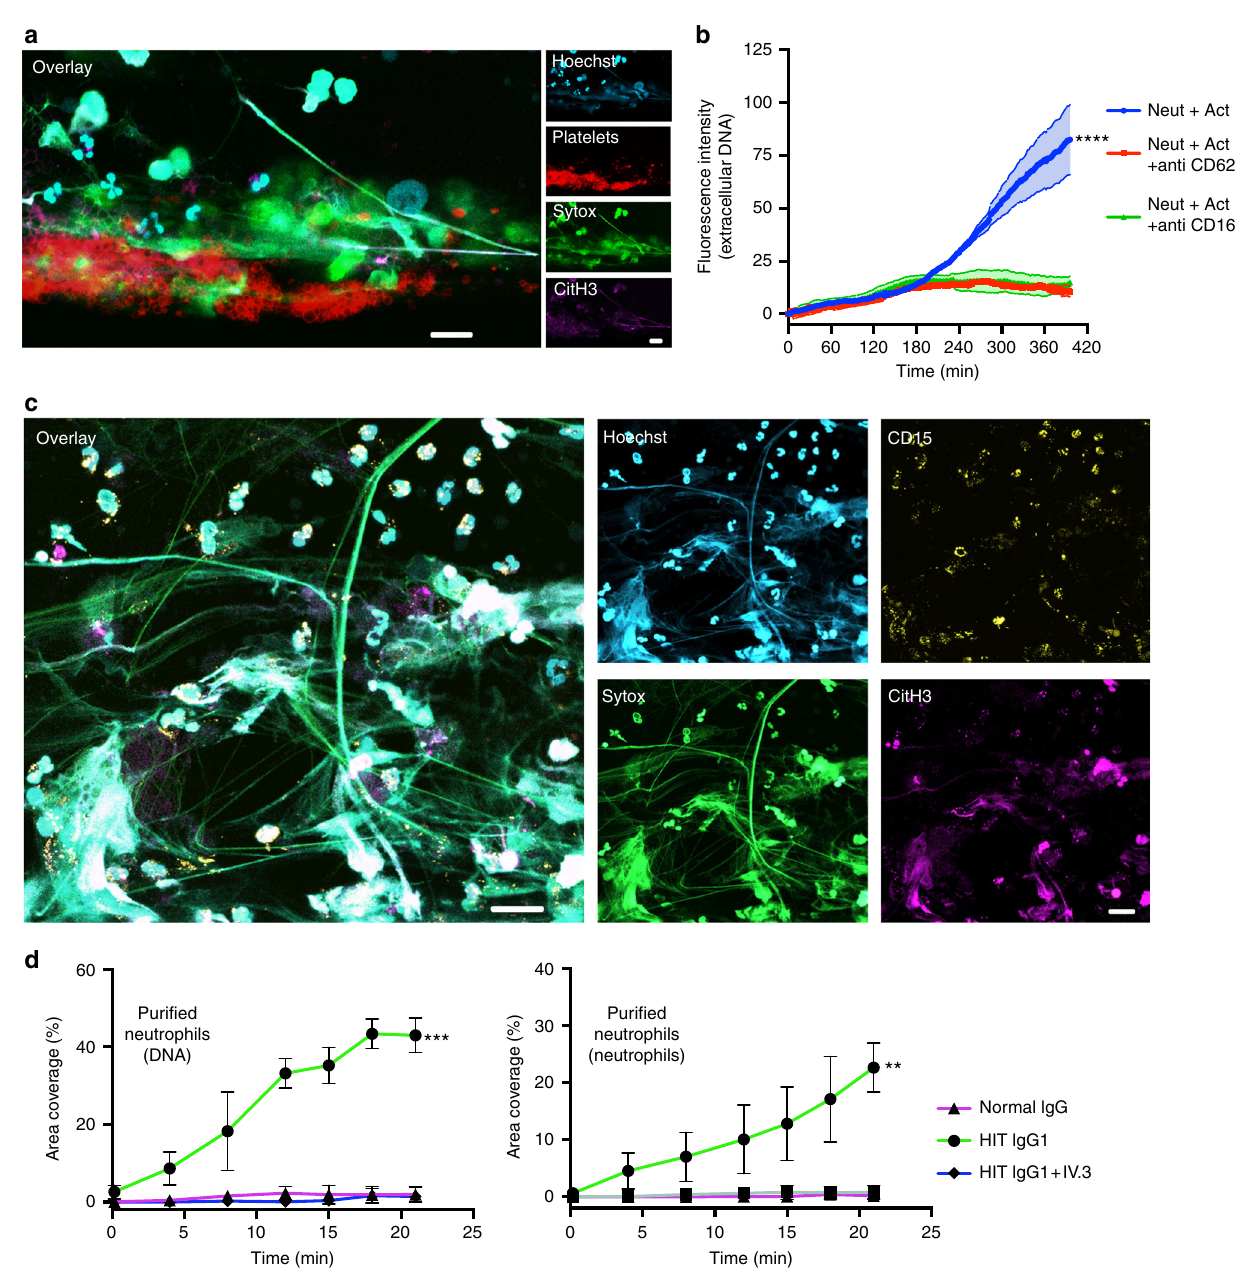
Fig. 4 HIT IgG induces NETosis via activated platelets and by direct neutrophil activation. a Platelets and neutrophils were resuspended in autologous plasma at a 20:1 ratio and incubated with KKO plus heparin at 37 °C for 1 h, platelets were stained with anti-CD41 Alexa 647 (red), neutrophils with Hoechst (blue), extracellular DNA with Sytox green (green), and CitH3 with anti-CitH3 Alexa 594 (magenta) and then perfused on VWF-coated microchannels at a shear stress of 67 dynes/cm 2 at 37 °C for up to 20 min. Samples were fi xed at the end of the experiment. Panels show confocal images of a representative thrombus of three individual experiments, using different donors imaged with a 63x oil immersion objective. Scale bar: 20 μ m. b Puri fi ed neutrophils were supplemented with HIT complex-activated platelets in the absence or presence of anti-CD62p or anti-CD162 and incubated at 37 °C. DNA release was monitored by confocal microscopy for over 5 h by Sytox green fl uorescence. Total DNA, Hoechst staining. The graph shows the fl uorescence intensity ratio of extracellular DNA/total DNA vs. time ( n = 3). c Puri fi ed neutrophils were resuspended in autologous plasma and incubated with KKO plus heparin at 37 °C for 1.5 h. Neutrophils were stained with anti-CD15 Alexa 647 (yellow), DNA with Hoechst (blue), the extracellular DNA with Sytox green (green) and CitH3 with anti-CitH3 Alexa 594 (magenta) and perfused on P-selectin-coated microchannels at a shear stress of 67 dynes/cm 2 at 37 °C for up to 30 min. Samples were fi xed at the end of the experiment. The panels show confocal images of a representative thrombus of three individual experiments, using different donors imaged with a ×40 water immersion objective. Scale bar: 20 μ m. d Percentage area coverage versus time of P-selectin-coated surfaces perfused with puri fi ed neutrophils in the presence of HIT IgG, normal IgG or HIT IgG plus IV.3 antibody (all in the presence of heparin). DNA (left panel), neutrophils (right panel). n = 3; Mean ± s.d. is shown. Statistics: one-way ANOVA with Tukey ’ s correction for multiple comparisons. ** P < 0.01; *** P < 0.001 ; **** P < 0.0001. Source data for ( b , d ) are provided as a Source Data fi